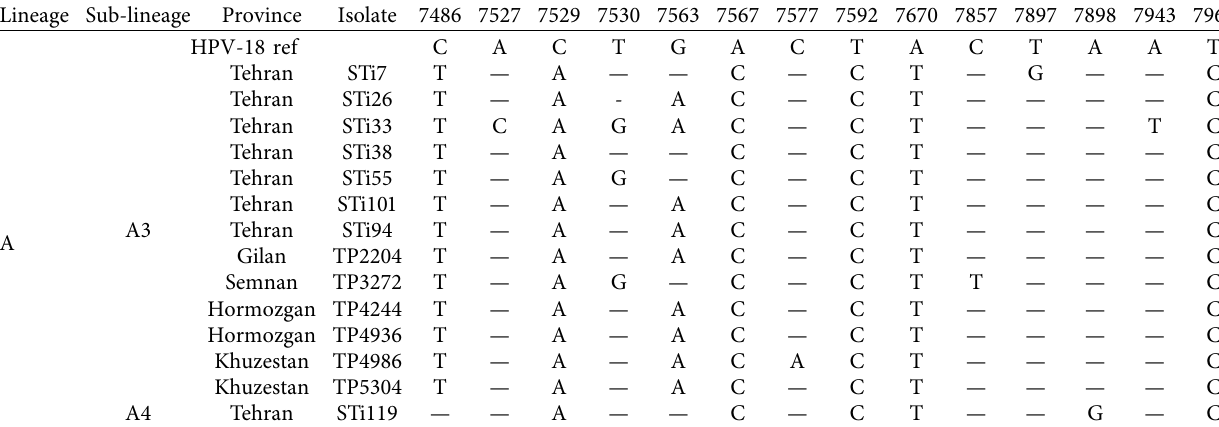
Table 2: All mutations in the studied HPV-18 isolates.